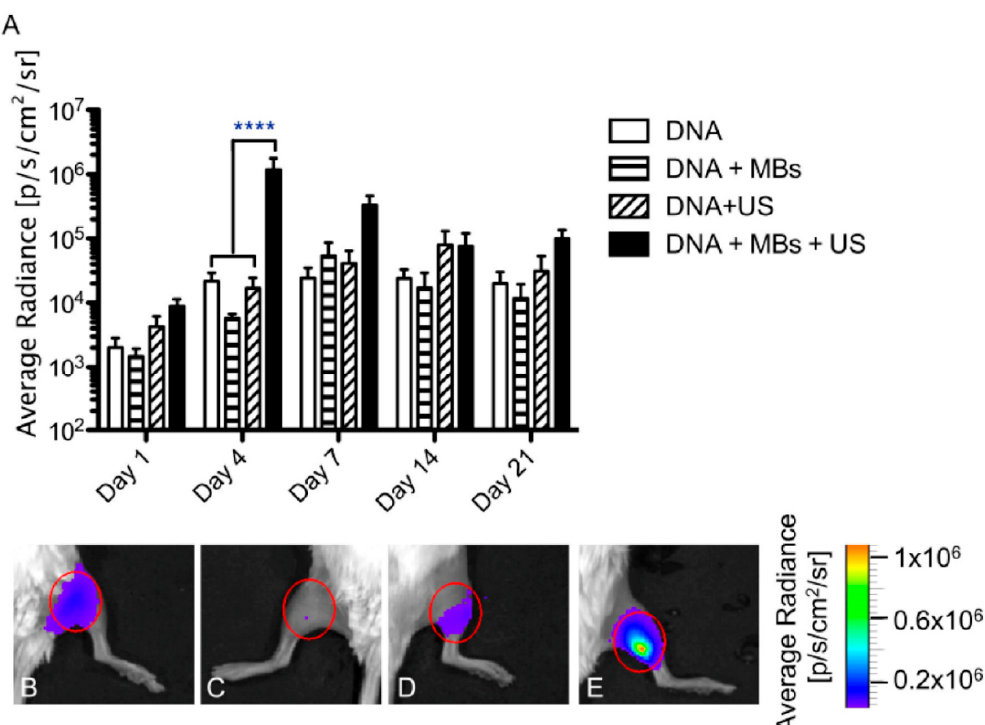
Figure 2. Luciferase 2 (Luc2) expression time course following sonoporation in vivo. ( A ). Luciferase expression profile in mice treated with microbubble-enhanced sonoporation of Luc2 (an enhanced form of Luciferase) in vivo. Mice were injected once with 50 µ g plasmid DNA (DNA and DNA + ultrasound (US) groups), or 50 µ g plasmid DNA premixed with 5 × 10 5 microbubbles (DNA + microbubbles (MBs) and DNA + MBs + US groups) and then treated with an acoustic pressure of 200 kPa for 2 min (DNA + US and DNA + MBs + US group). The treatment e ff ect was monitored using bioluminescence imaging for 21 days after treatment. ****, p < 0.05 relative to control. ( B–E ). Representative images obtained in each group (DNA, DNA + MBs, DNA + US, and DNA + MBs + US, respectively) on Day 4 with the region of interest indicated by a red oval. Color bar, p / s / cm 2 / sr. (Reprinted from Shapiro et al. [10] with permission.)